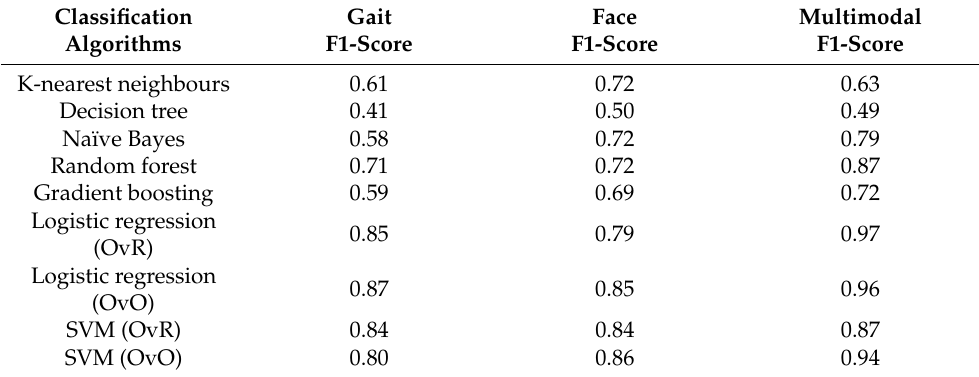
Table 8. F1-score comparison on different classifiers of unimodal and multimodal